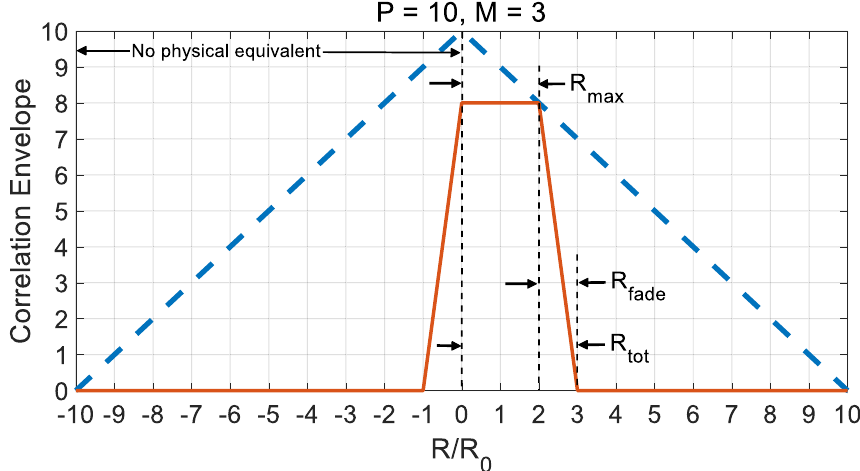
2 , L RFB = − 0.97 (cid:31)